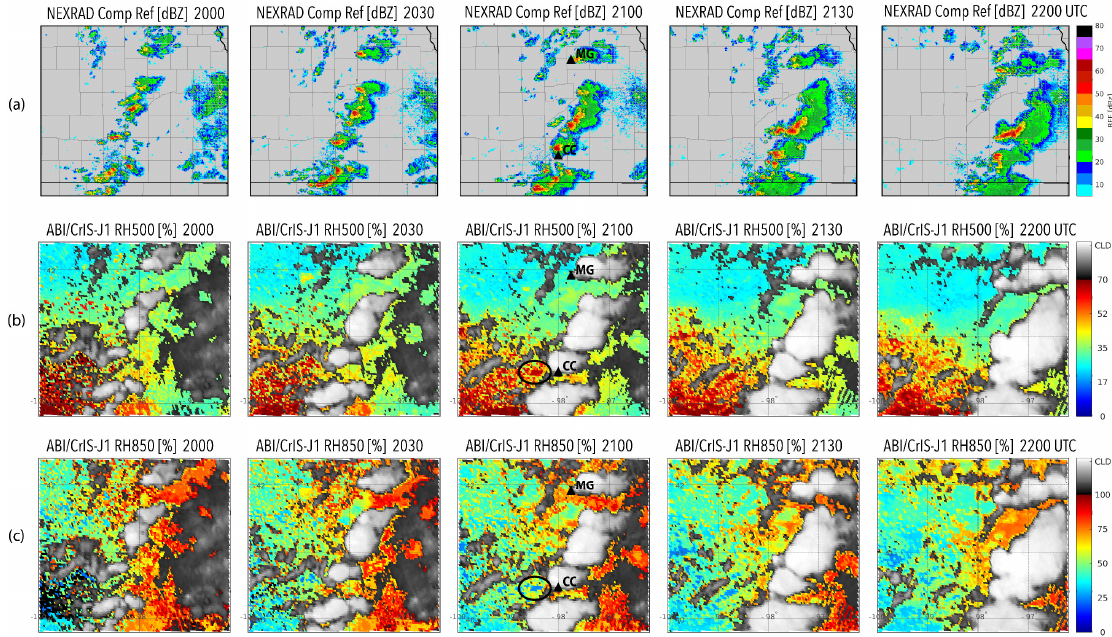
Figure 6. ( a ) NEXRAD composite reflectivity in [dBZ]; ( b ) ABI/CRIS ‐ J1 fusion results for relative humidity (RH) in [%] at 500 hPa; and ( c ) ABI/CRIS ‐ J1 fusion results for relative humidity (RH) in [%] at 850 hPa every 30 min from 2000 UTC to 2200 UTC on 5 May 2021 in Nebraska. ABI Band 15 (12.3 μ m) brightness temperatures are shown in the background of panels ( b , c ). Tornado touch ‐ down locations (MG and CC) are marked in the 2100 UTC panels, and an example of a low ‐ level dry air pocket are highlighted and ovals panels ( b , c ) at 2100 UTC. Note the different color scale for panels b and c.